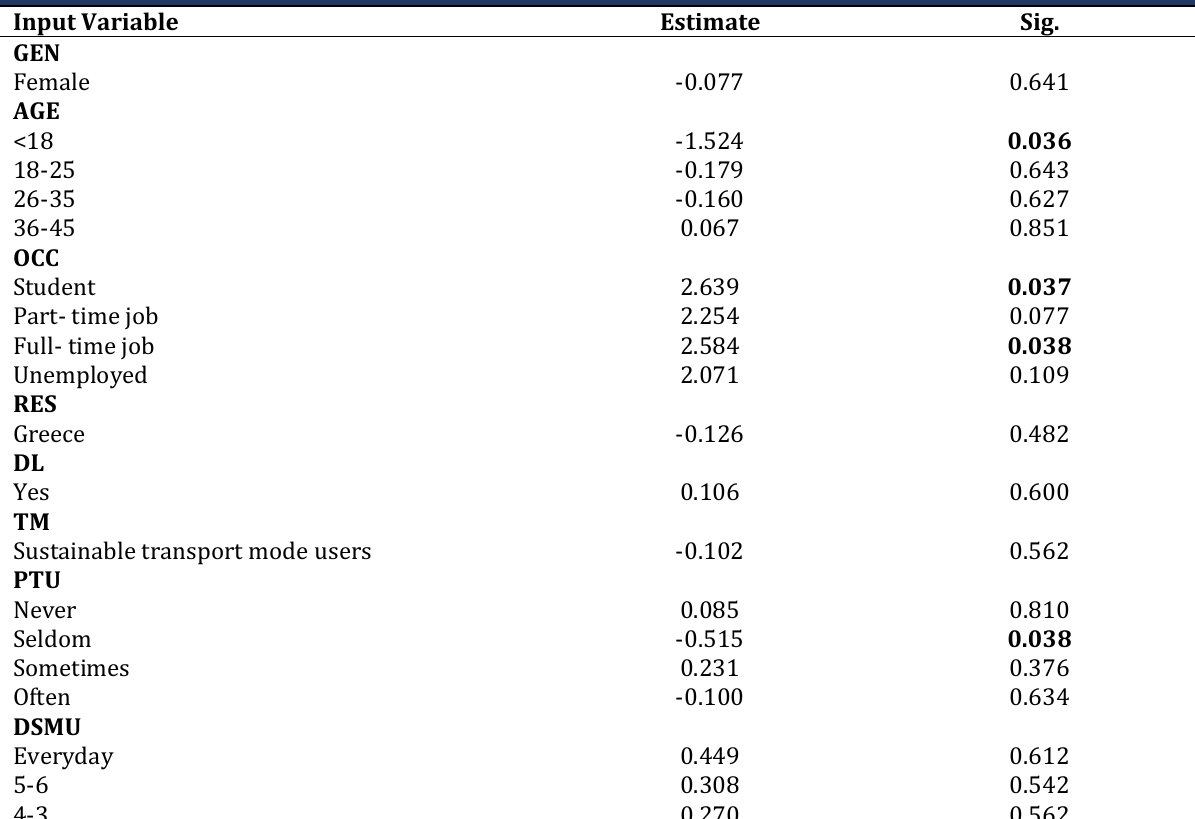
Table 5: Parameter estimates for Model IV Input